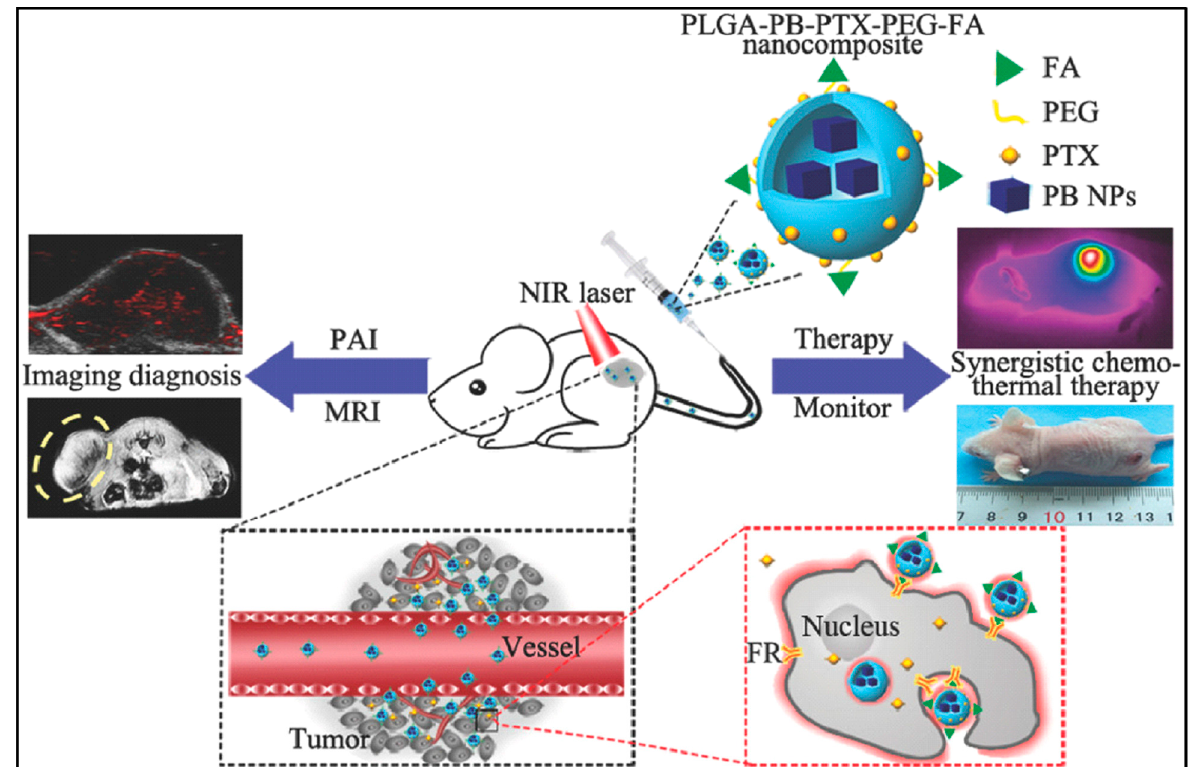
Figure 5. Schematic representation of PLGA–PB–PTX–PEG–FA nanococktail and its corresponding targeted theranostic performance, including PA/MRI-guided synergistic NIR-triggered PTT and chemotherapy. Reproduced with permission from [13].